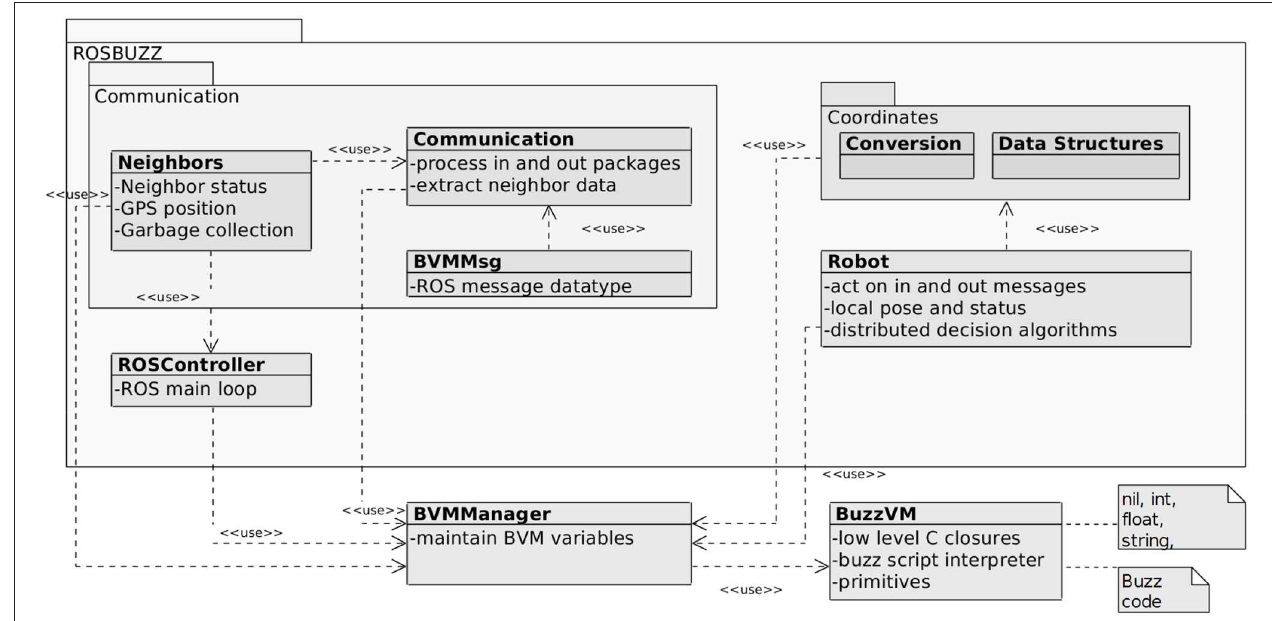
FIGURE 1 | Simplified class diagram of the ROSBuzz software architecture: step-based BVM (lower right) integrated to the event-based ROS ecosystem.